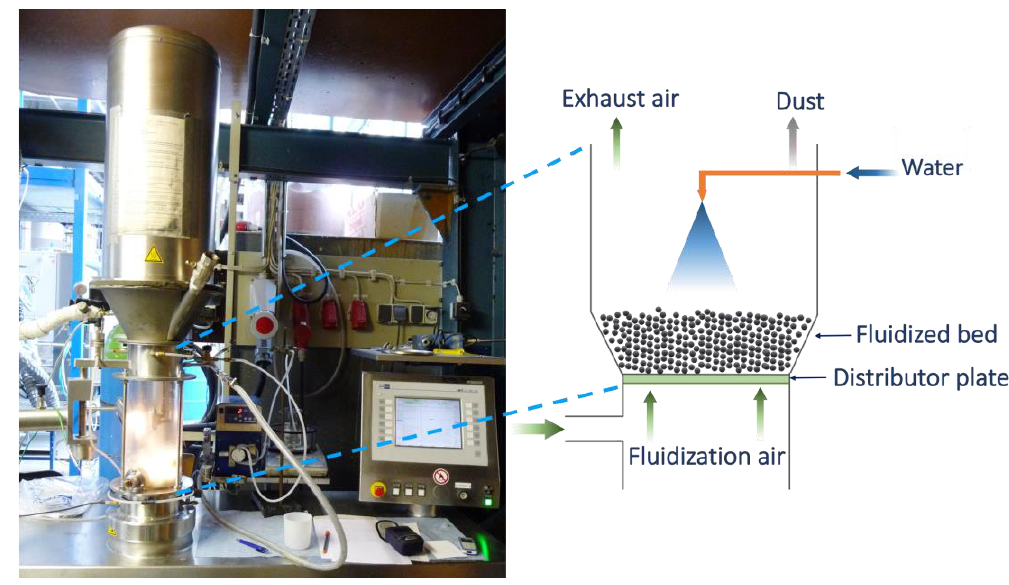
Figure A1. The experimental setup with a laboratory-scale fluidized bed agglomerator.